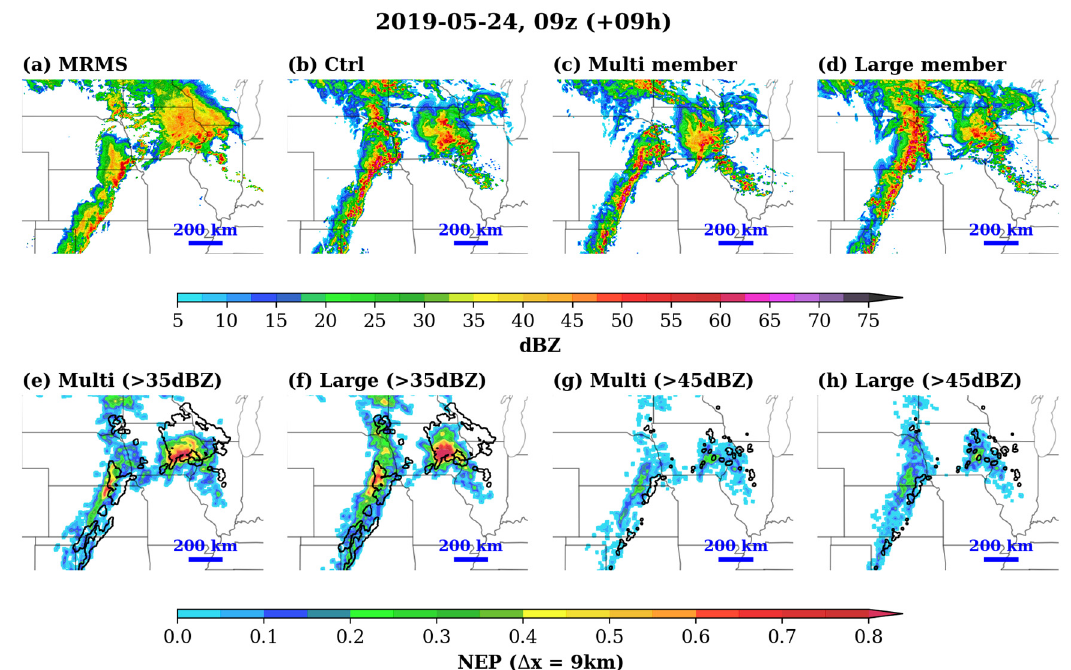
Figure 8. Reflectivity for selected subdomain for ( a ) MRMS, ( b ) 9h control forecast, ( c ) selected MULTI member, and ( d ) selected LARGE member, as well as NEPs for ( e ) MULTI with 35 dBZ threshold, ( f ) LARGE with 35 dBZ threshold, ( g ) MULTI with 45 dBZ threshold, and ( h ) LARGE with 45 dBZ thresholds valid at 09z, 24 May 2019. All NEPs were derived with a neighborhood size of 9 km.